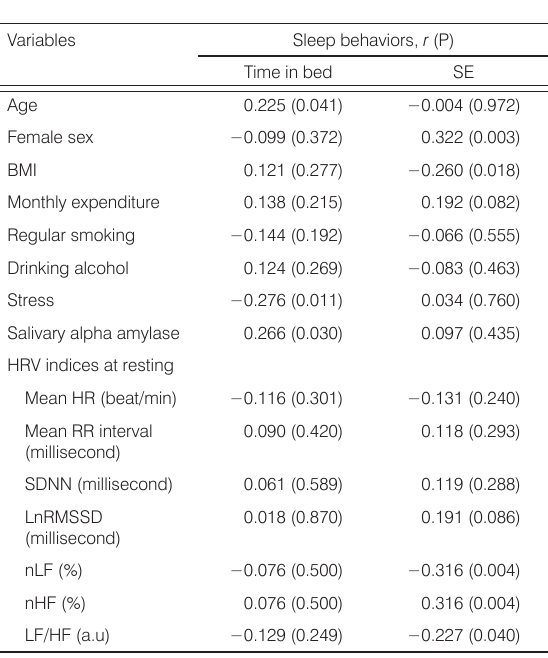
Table 1. General characteristics and study variables in the participants ( N = 86).